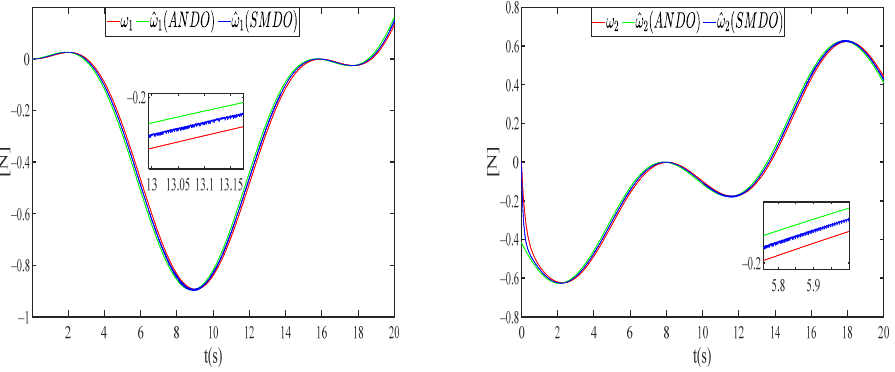
Figure 5. The disturbance estimation comparation in ω 1 and ω 2 .